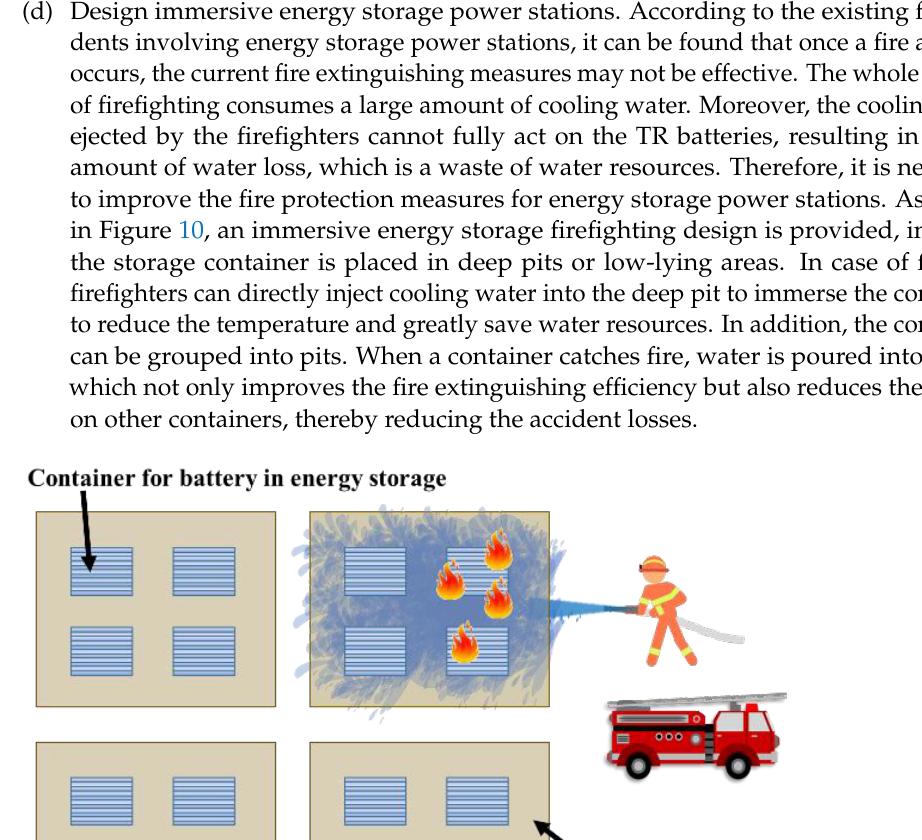
Figure 9. Structure design of a firewater injection port for EVs.